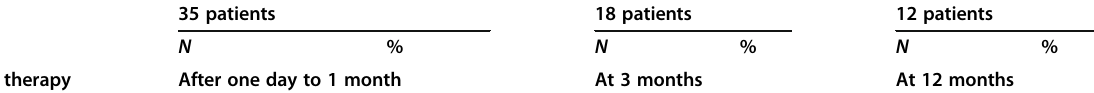
Table 7 Side effects following medical cannabis therapy in a cohort of 35 Italian patients with fibromyalgia